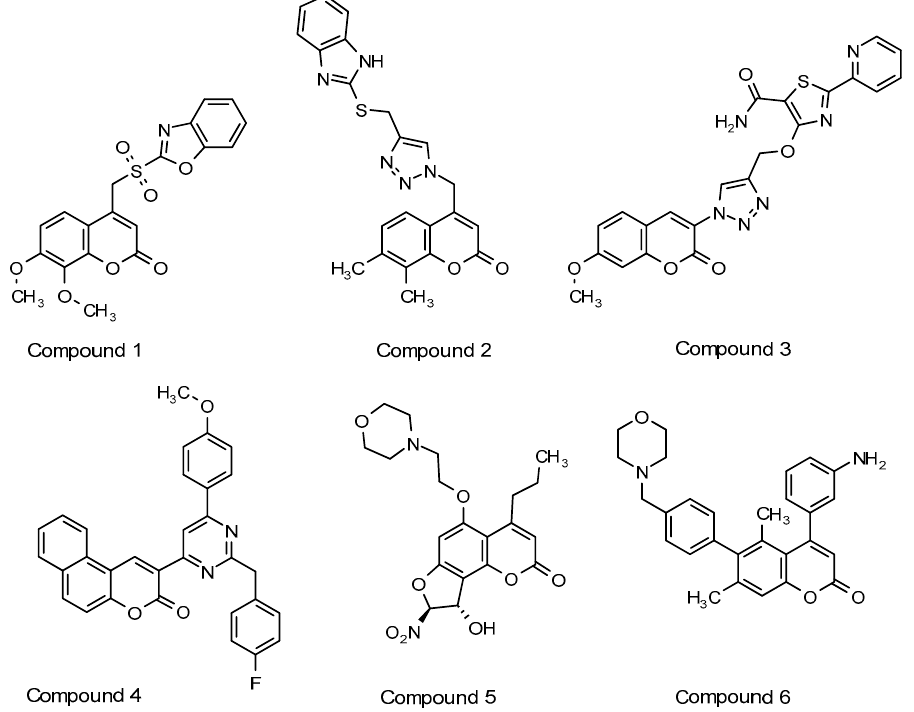
Figure 2. Selected coumarin derivatives demonstrating promising Mycobacterium tuberculosis activity across various assays.